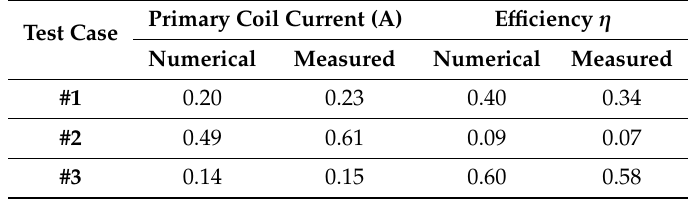
Table 4. Calculated and measured I 1,RMS (A) and e ffi ciency η .